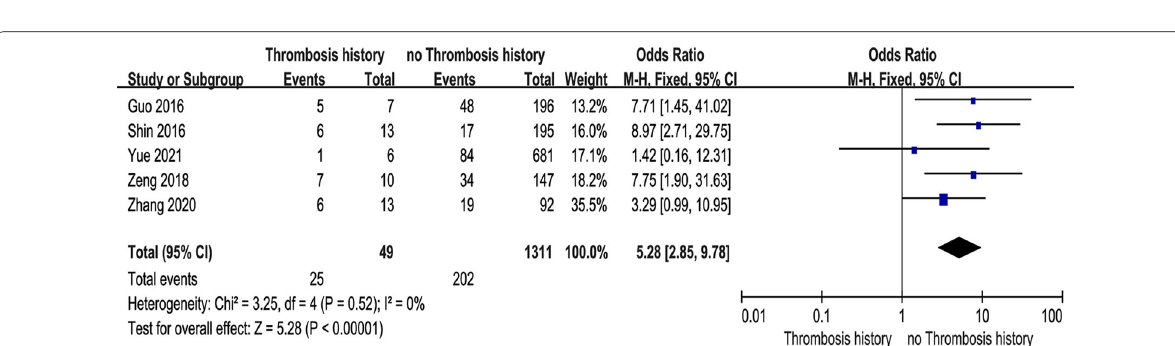
Fig. 11 Forest plot showing the relationship between patients with a history of thrombosis and preoperative DVT in 2 groups. CI confidence interval, df degrees of freedom, M-H Mantel–Haenszel